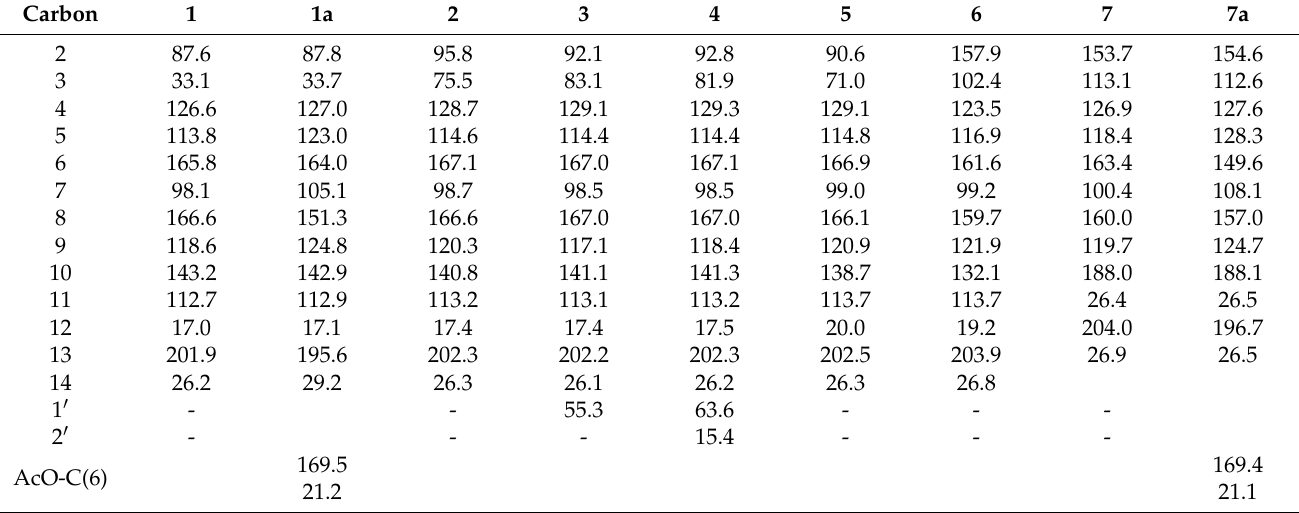
Table 1. 13 C NMR data of compounds 1 – 7 , 1a , and 7a